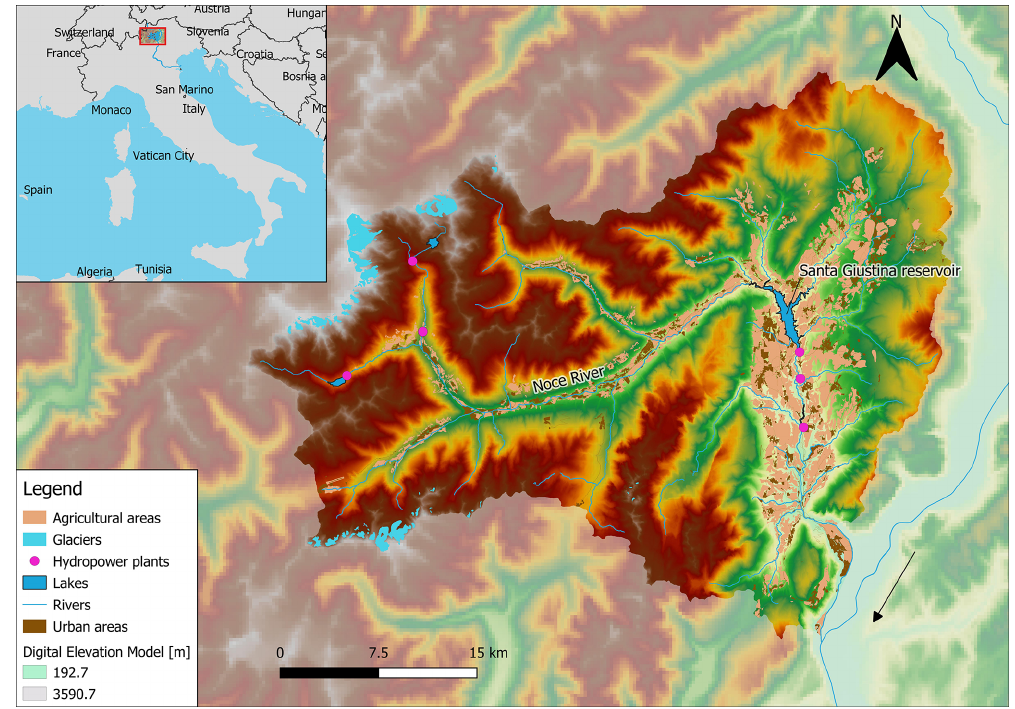
Figure 1. Noce River basin and main characteristics. The black arrow specifies the Adige River flow